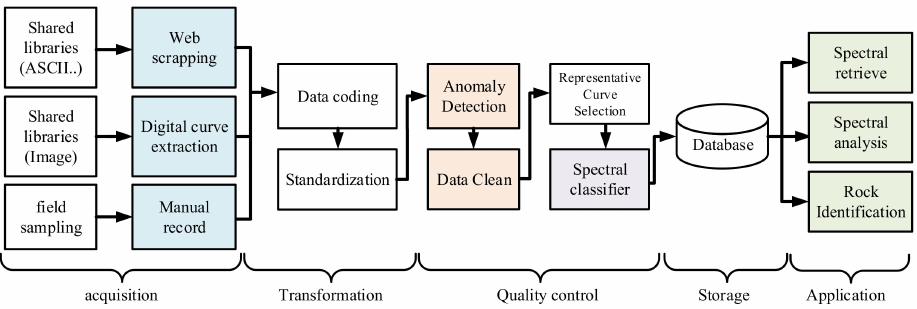
Figure 4. Workflow of RockSL